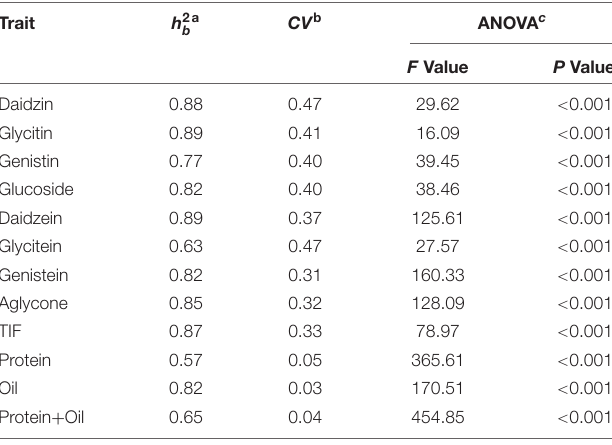
TABLE 3 | The statistical analysis of 12 quality traits in the three experimental locations (Harbin, Mudanjiang, Hailun).